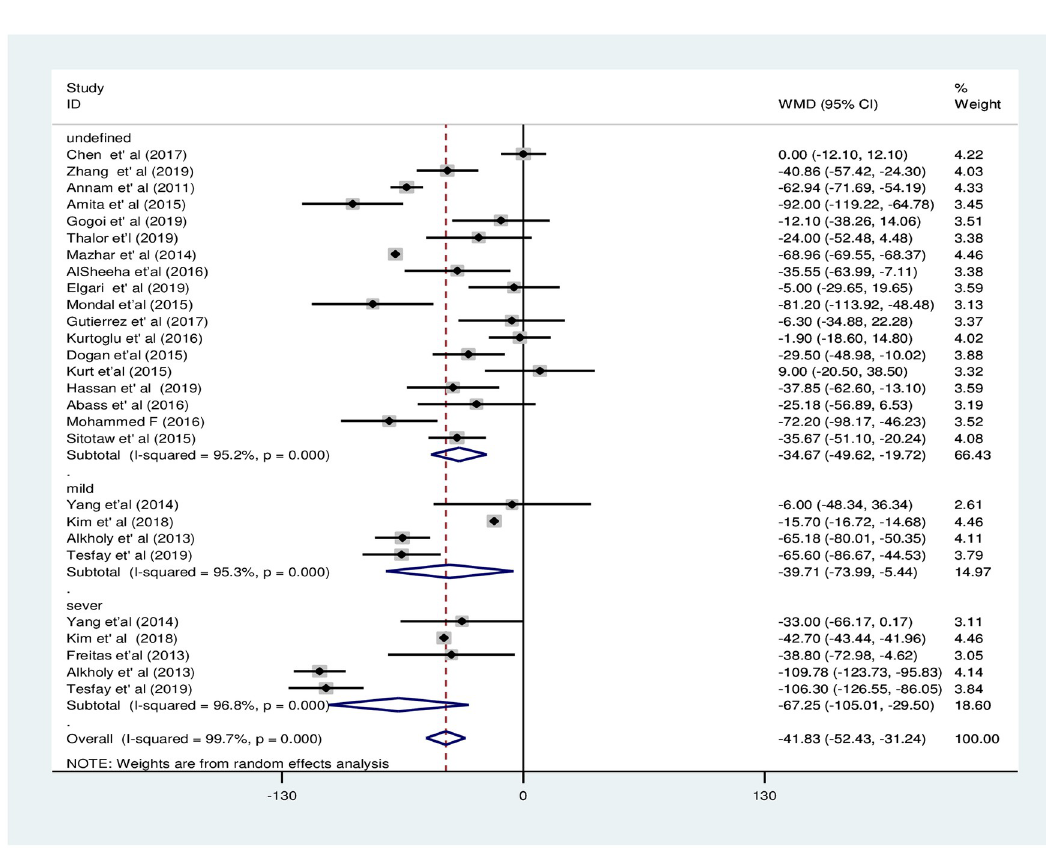
Fig 6. Forest plot of subgroup analysis for the pooled WMD estimate of PC by PE severity.